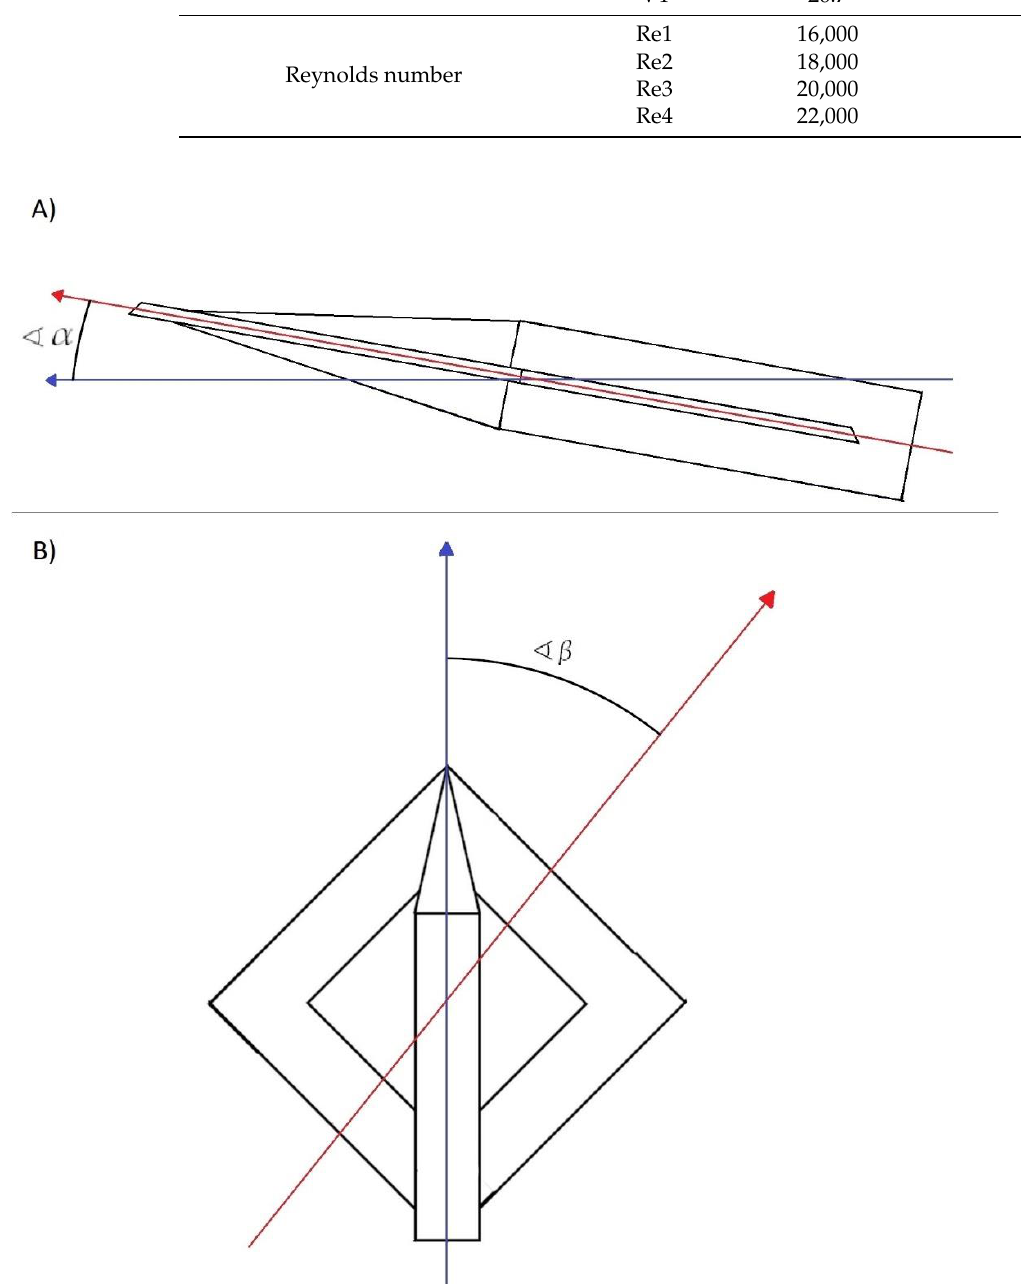
Figure 3. Image showing ( A ) α (attack angle) and ( B ) β (sliding angle) in different surfaces. Table 1. The 2D-Sweep static test parameters. A total of 32 2D-Sweep static tests were